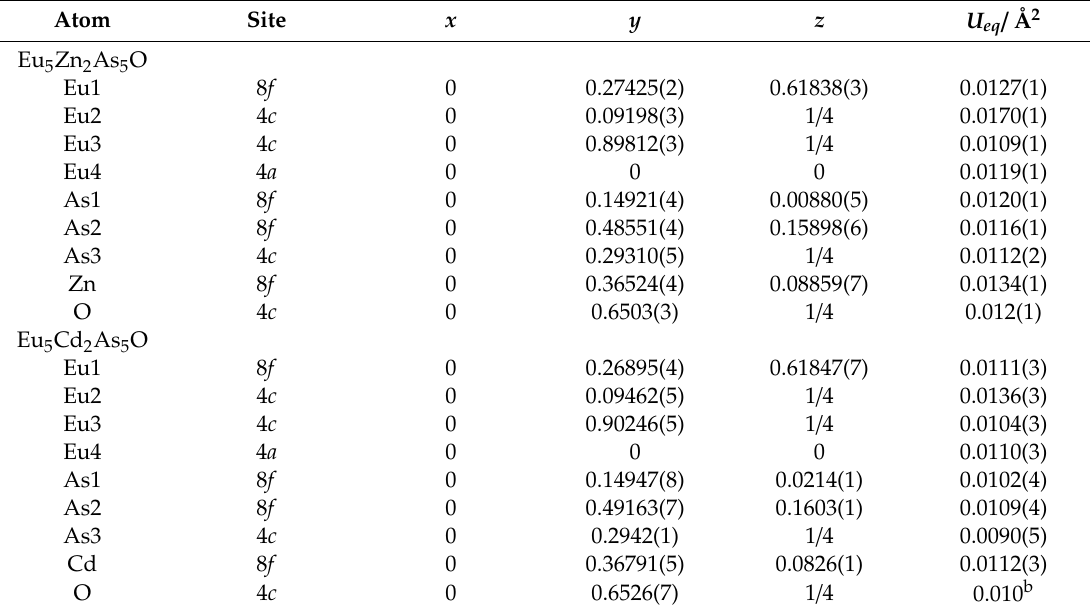
Table 2. Refined atomic coordinates and equivalent isotropic displacement parameters ( U eq a ) for Eu 5 Zn 2 As 5 O and Eu 5 Cd 2 As 5